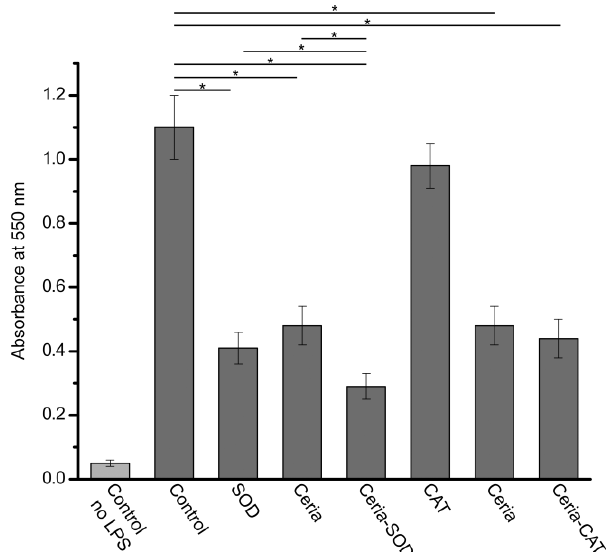
Figure 3. The results of the Griess test conducted for SOD- and CAT-ceria conjugates, and non- functionalized ceria, superoxide dismutase and catalase. The measured absorbance at 550 nm is directly correlated with the content of ∙NO 2 in the cell culture media. Asterisks represent significant difference between values ( p < 0.05, n =